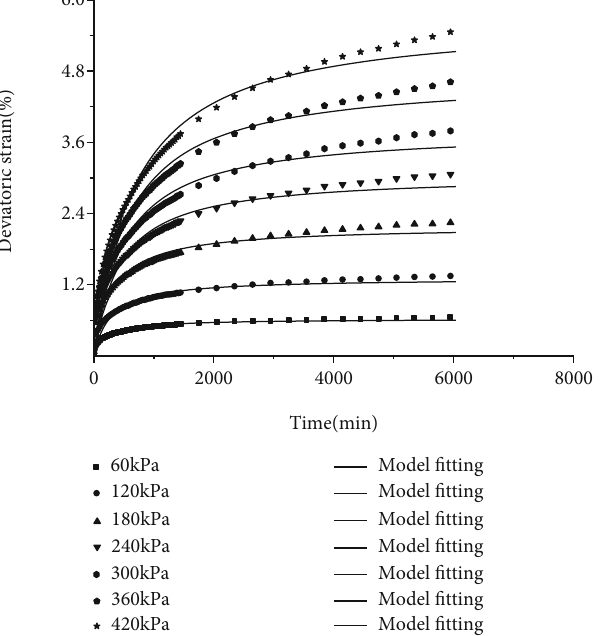
Figure 12: Fitting curves of total stress creep curve of intact